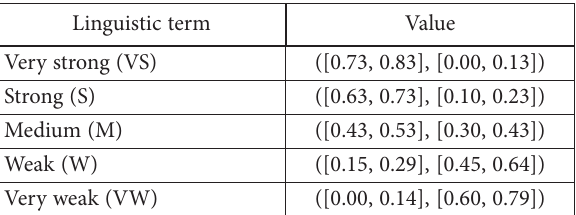
Table 1. Linguistic phrases for assessing the alternatives Linguistic term